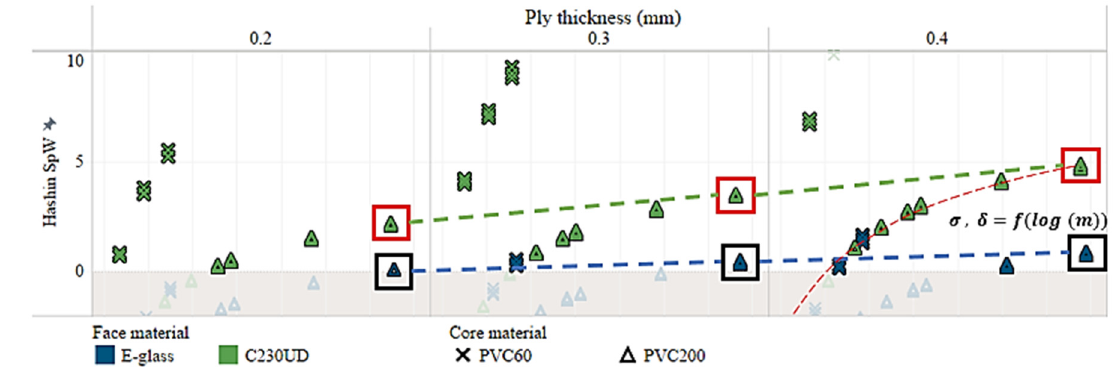
Figure 19. The influence of ply thickness on the Hashin failure criteria. The red square boxes indicate carbon fibre face sheet while the black square boxes indicate E-glass. Face material are denoted by colour while core materials are denoted by symbols.